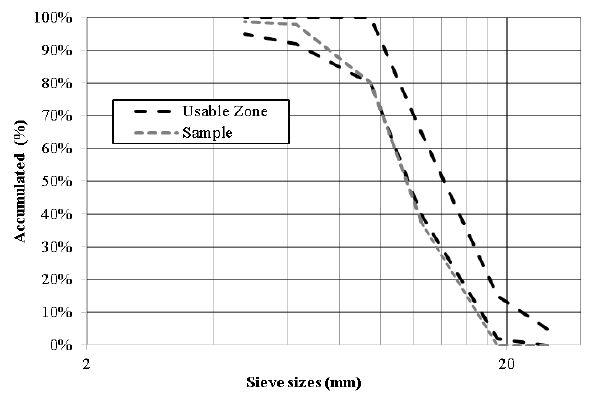
Figure 3. Particle size distribution of coarse aggregate.